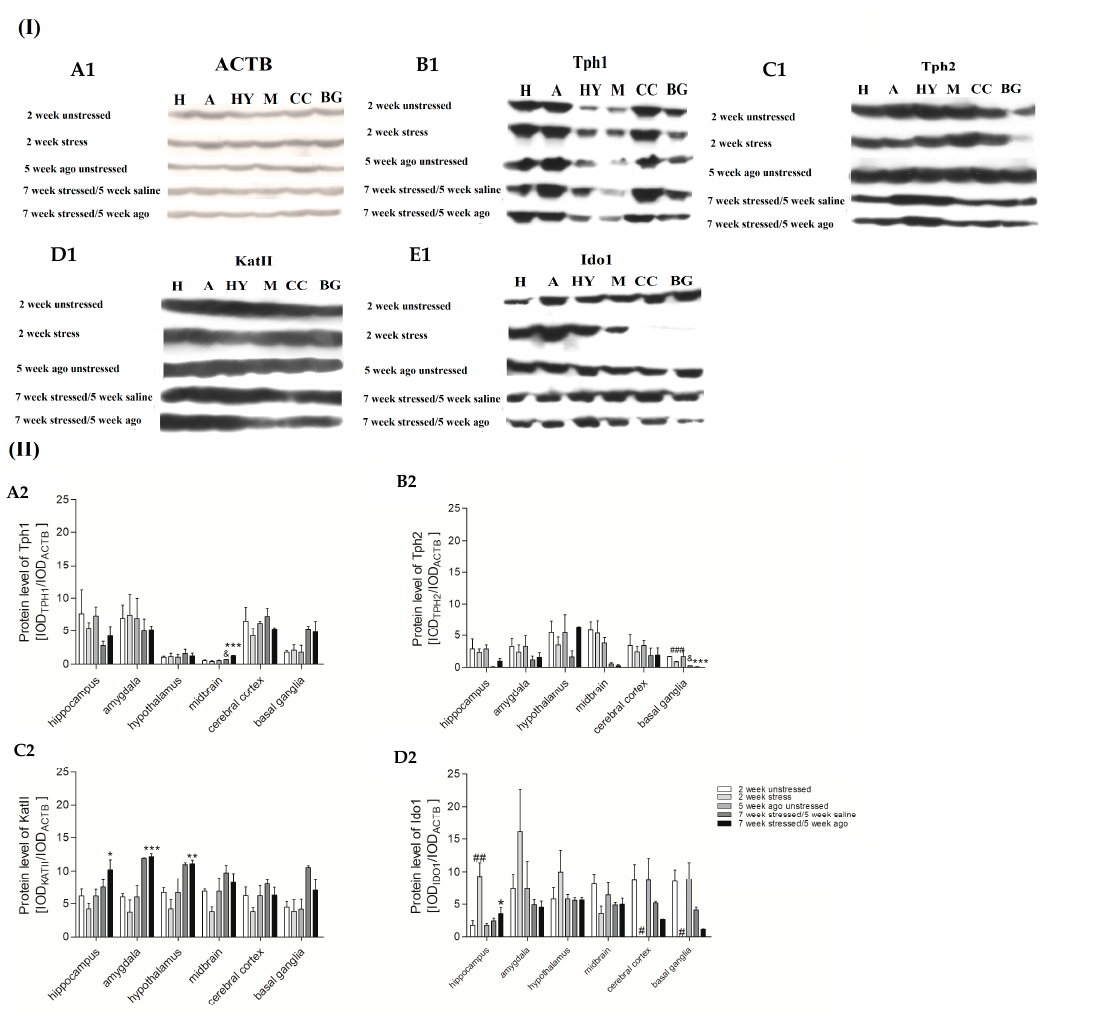
Figure 5. ACTB ( A1 ), Tph1 ( B1 ), Tph2 ( C1 ), KatII ( D1 ), and Ido1 ( E1 ) protein expression in six brain structures of rats exposed to CMS for two weeks (2 weeks unstressed, 2 weeks stressed) and in animals exposed to CMS for seven weeks and administered vehicle (1 mL / kg) or agomelatine (10 mg / kg) for five weeks (5 weeks agomelatine unstressed, 7 weeks stressed / 5 weeks saline, and 7 weeks stressed / 5 weeks agomelatine). ( I ) Representative Western blot analysis in the hippocampus (H), amygdala (A), hypothalamus (HY), midbrain (M) cerebral cortex (CC), and basal ganglia (BG) of 2 weeks unstressed, 2 weeks stressed, 5 weeks agomelatine unstressed, 7 weeks stressed / 5 weeks saline, and 7 weeks stressed / 5 weeks agomelatine groups. ( II ) Levels of Tph1 ( A2 ), Tph2 ( B2 ), Ido1 ( C2 ), and KatII ( D2 ) proteins measured in hippocampus, amygdala, hypothalamus, midbrain, cortex, and basal ganglia. Samples containing 25 µ g of proteins were resolved by SDS-PAGE. The intensity of bands corresponding to Tph1, Tph2, Ido1, and KatII was analyzed by densitometry. Integrated optical density (IOD) was normalized by protein content and a reference sample (see Section 2 for details). The graphs show the mean IODs of the bands from all analyzed samples. The IOD gene / IOD ACTB method was used to estimate the relative protein expression levels in the analyzed samples. Data represent means ± SEM; n = 6; # p < 0.05, ## p < 0.01, ### p < 0.001 for di ff erences between 2 weeks stressed and 2 weeks unstressed groups; * p < 0.05, ** p < 0.01, *** p < 0.001 for di ff erences between 2 weeks stressed and 7 weeks stressed / 5 weeks agomelatine; & p < 0.05 for di ff erences between 7 weeks stressed / 5 weeks saline and 7 weeks stressed / 5 weeks agomelatine